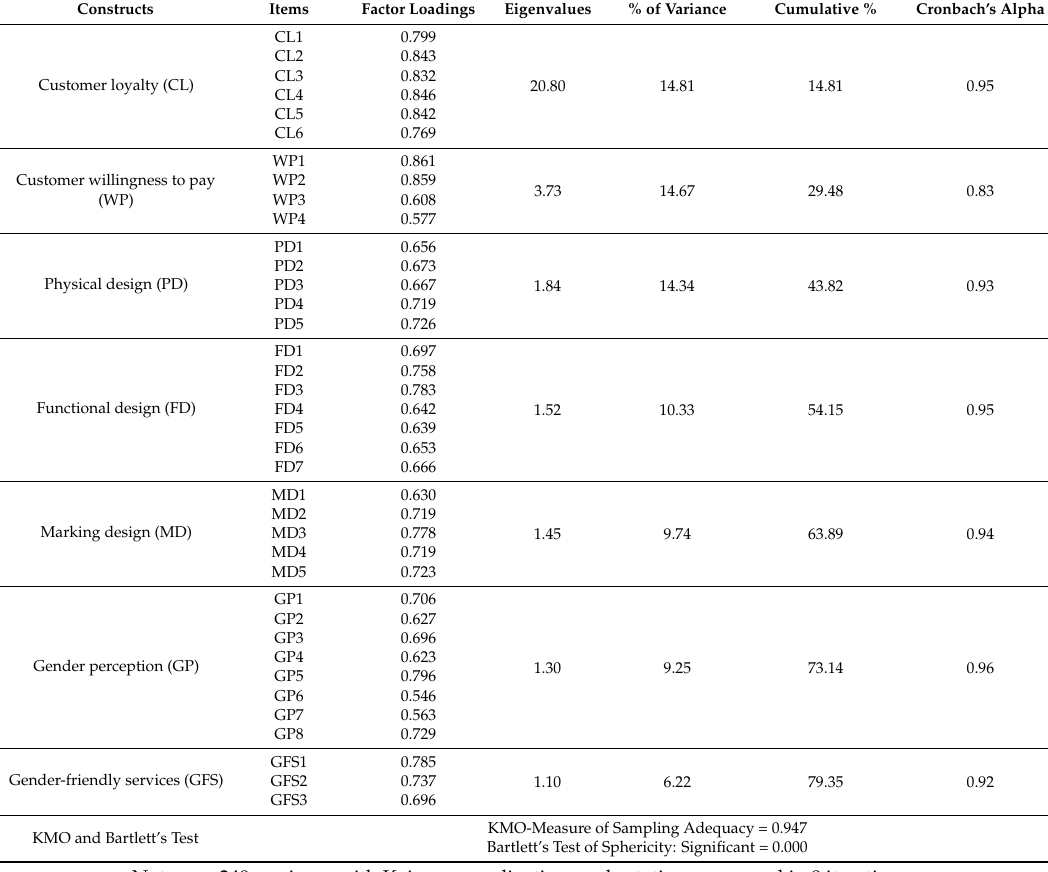
Table 4. Results of the constructs and items of the measurement scale (Study 2, n =